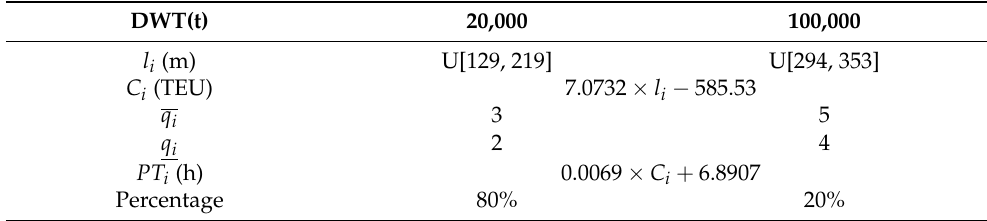
Table 1. Ship parameters for generating instances.